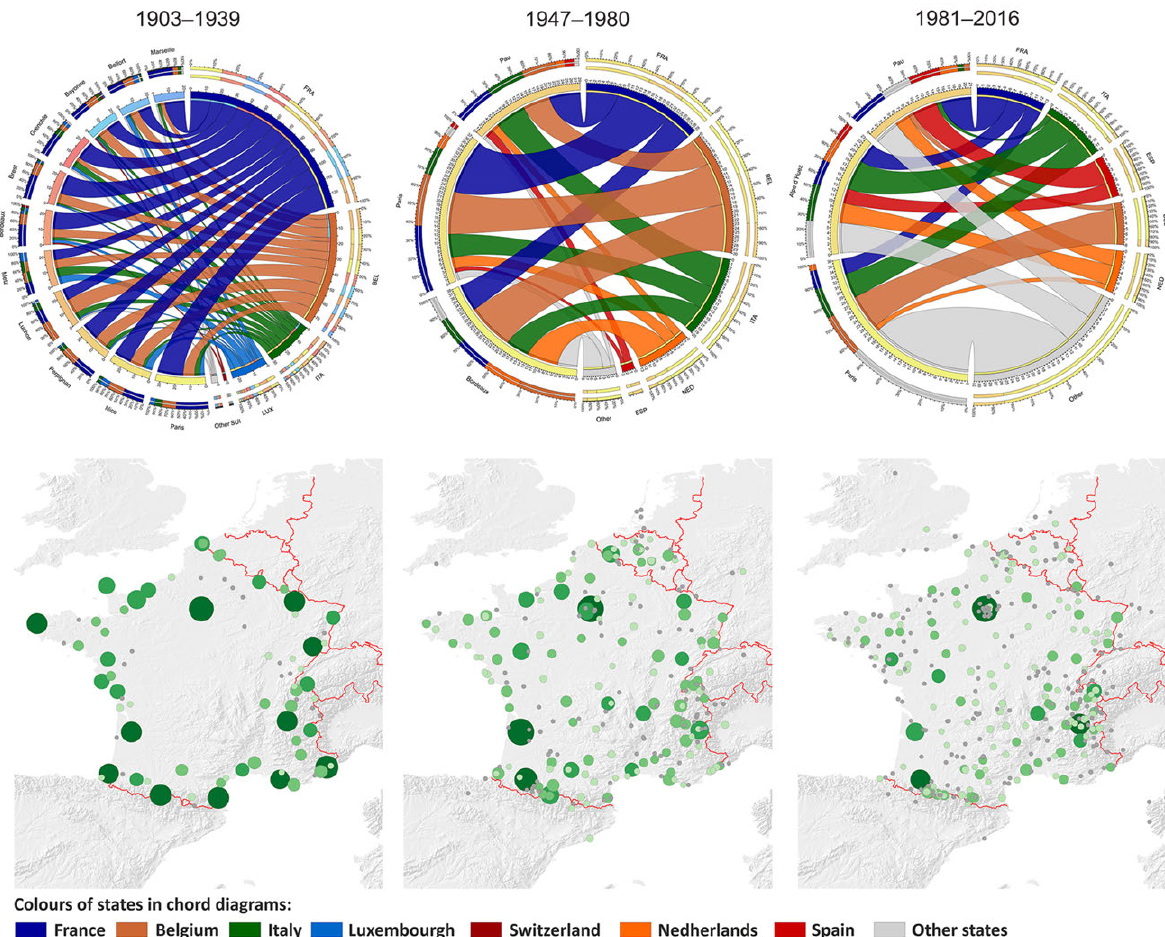
Fig. 7. Stable finish places of the Tour de France with more than 20 finishes within the given time span (below the diagrams, the maps show all stage finishes in the relevant